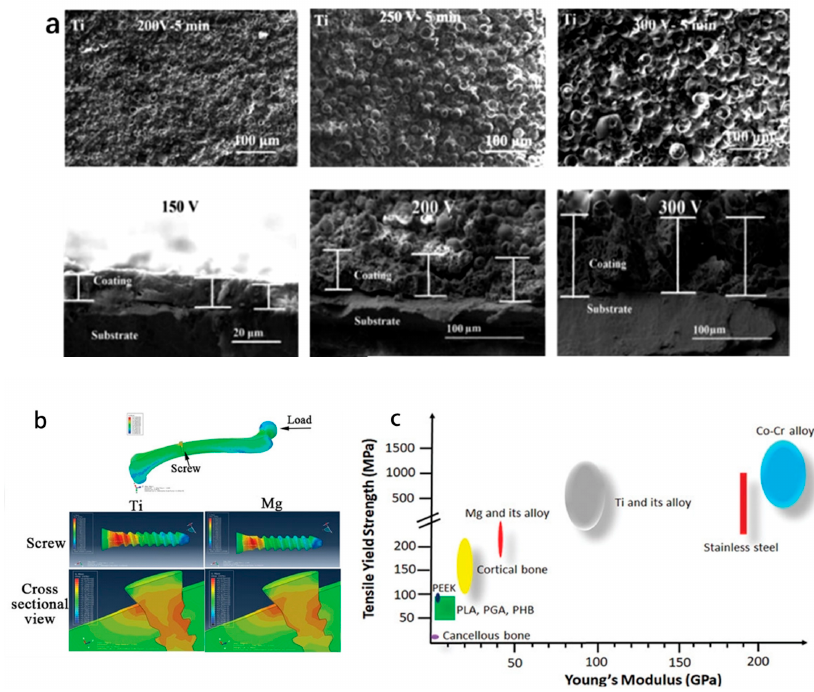
Figure 2. Research related to Ti: ( a ) SEM micrographs of wollastonite calcium phosphate (W-CaP) coatings on Ti surface, and SEM micrographs of cross-sectional W-CaP coatings produced on Ti at different voltages [64]; ( b ) plot of peak stress distribution in a finite element analysis model consist- ing of the femoral head and the inserted titanium or magnesium screw, where the data surface has a lower stress distribution in the bone tissue around the titanium screw compared to the magne- sium-based screw and the stress at the surface titanium-implant–bone interface shield [48]; ( c ) ten- sile yield strength distribution range of each biomaterial [48].